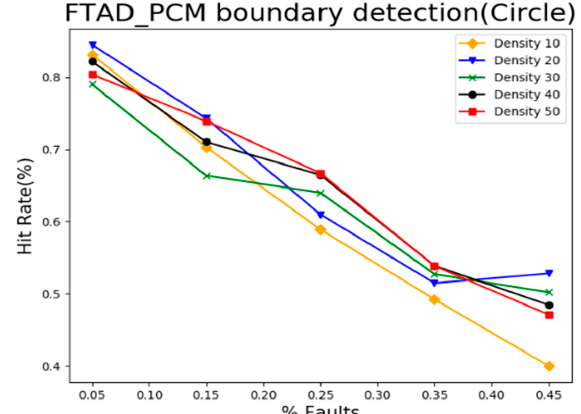
Figure 6. FTAD_PCM boundary detection (circle).